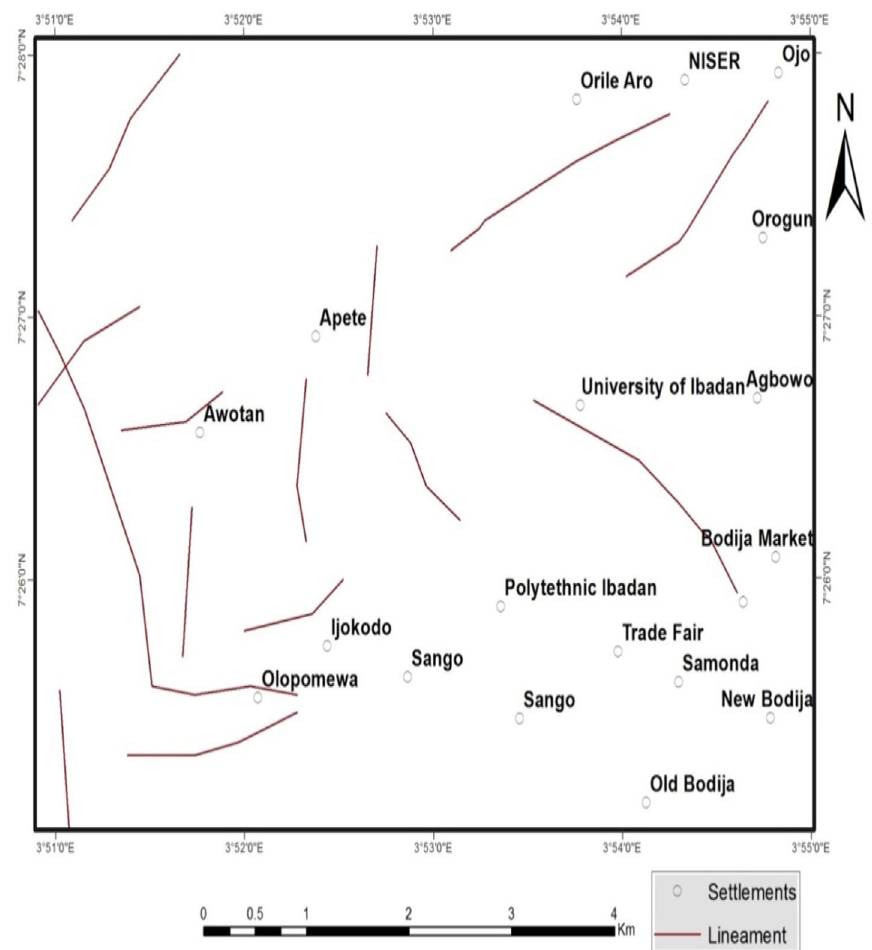
Fig. 5 Lineament map of the study